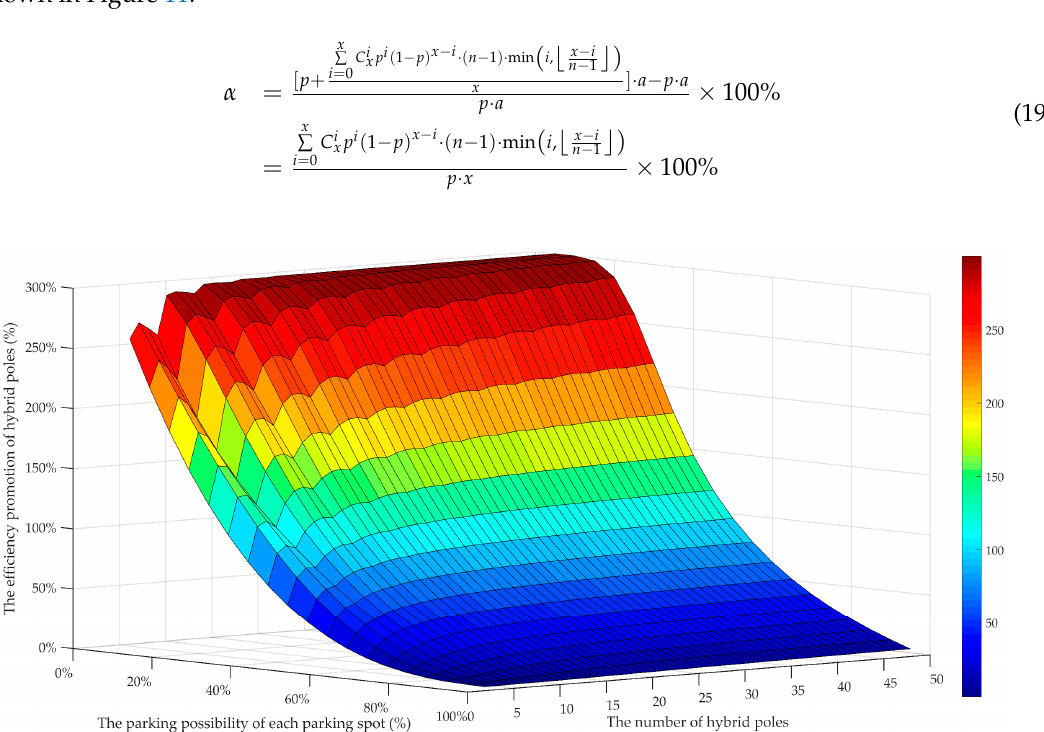
Figure 11. The functional image of the promotion of hybrid poles relative to traditional poles under binomial distribution.